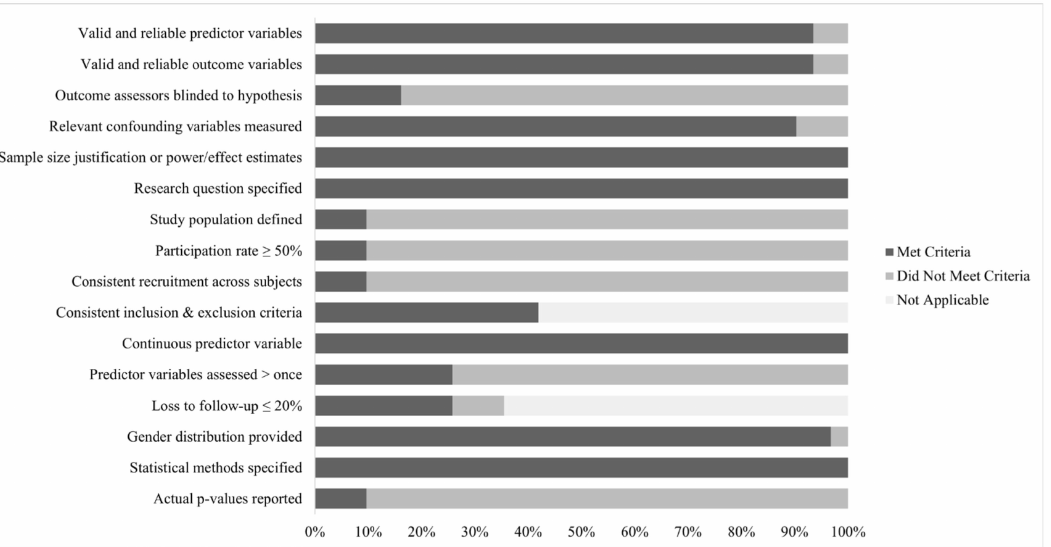
Figure 2. Quality assessment. Note. Bars represent the percentage of studies (out of 31) that fulfilled each criterion of the quality assessment.